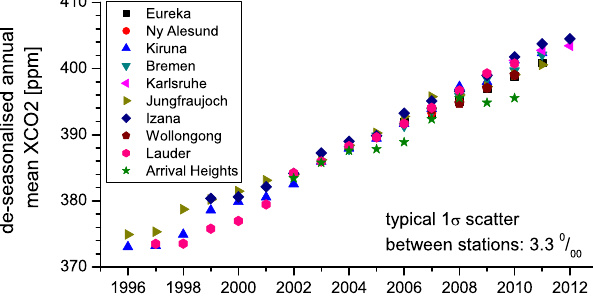
Fig. 11. Deseasonalised annual mean MUSICA XCO2 product as retrieved at the ten NDACC stations of Fig. 1. The typical 1 σ scatter between stations is the typical standard deviation of the deseasonalised annual mean measured at the different stations for the same year.